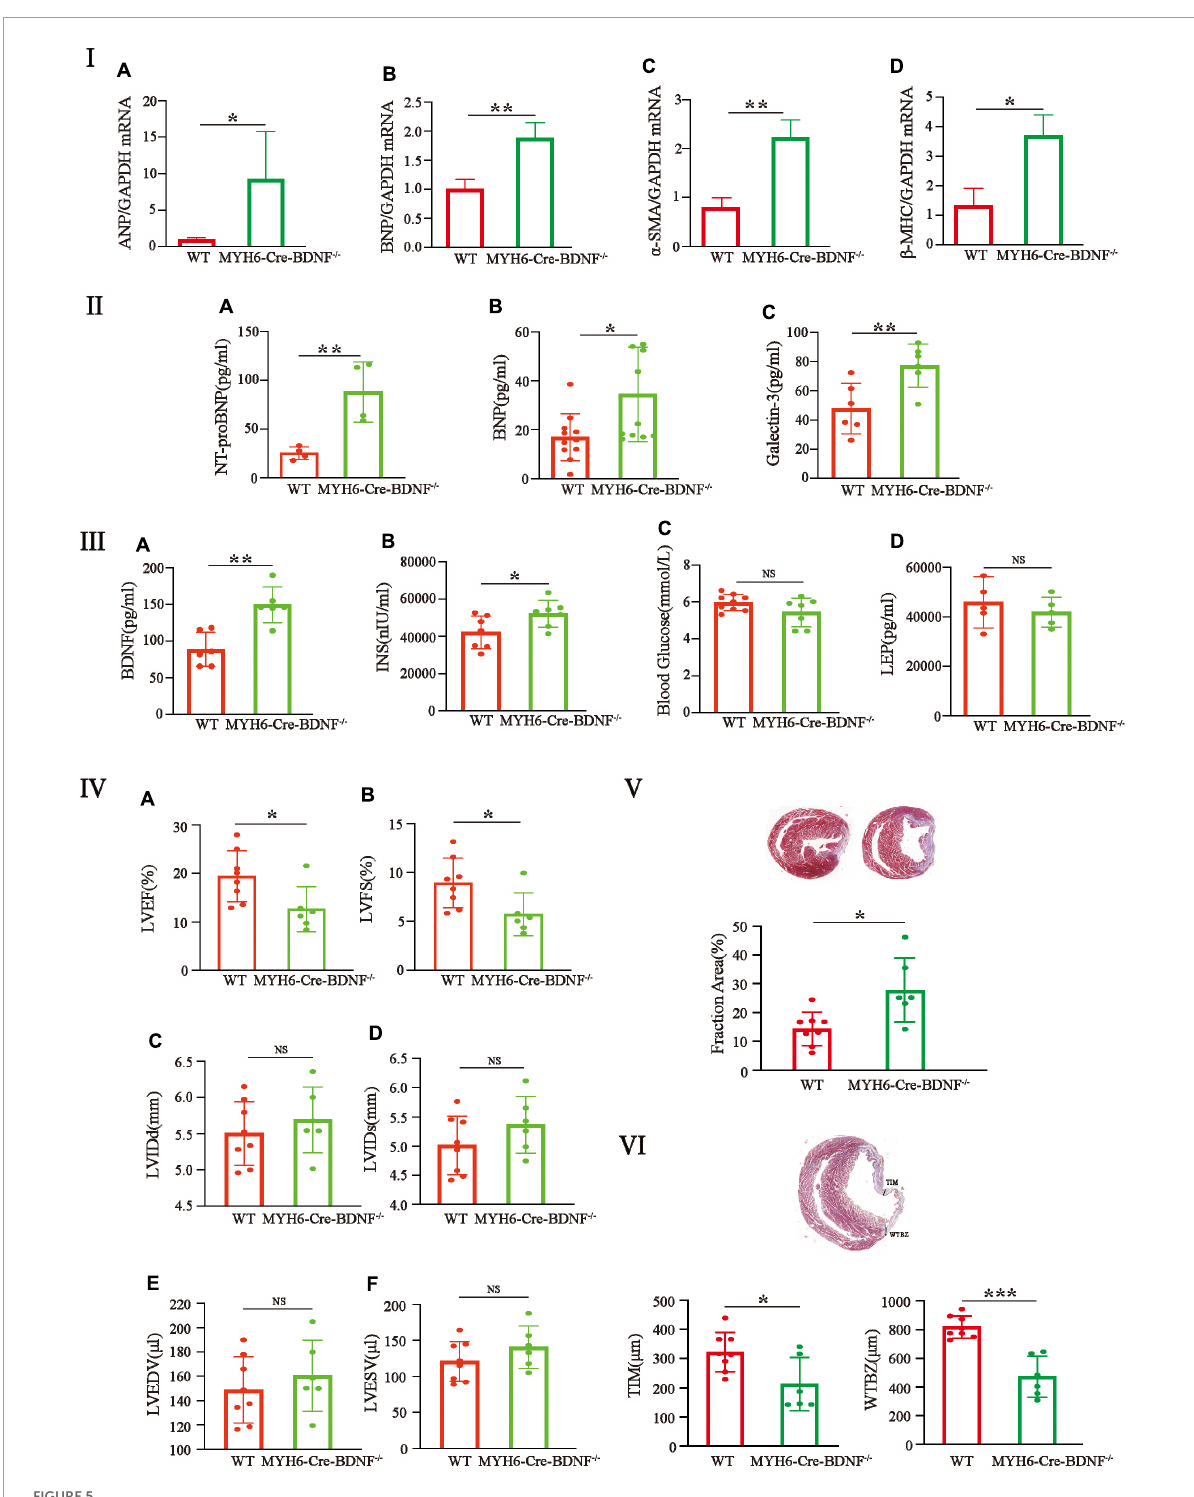
FIGURE5 Significant increases in heart failure indices, pathological hypertrophy in the left ventricle, serum BDNF and insulin levels and poor cardiac function and regeneration are found in young adult MYH6-Cre-BDNF − / − mice: (I–III) The qPCR results showed that the expression of the heart failure markers atrial natriuretic peptide (ANP) (Ia) and brain natriuretic peptide (BNP) (Ib) was significantly higher in the left ventricle of 3-month-old MYH6-Cre-BDNF − / − hearts than in that of WT hearts. The analysis of the heart failure indices, N-terminal pro-brain natriuretic peptide (NT-proBNP), BNP and Galectin-3, also confirmed that serum levels of NT-proBNP (IIa) , BNP (IIb) and Galectin-3 (IIc) in 3-month-old MYH6-Cre-BDNF − / − mice were significantly higher than those in WT mice. In addition, qPCR showed that compared to WT, the expression